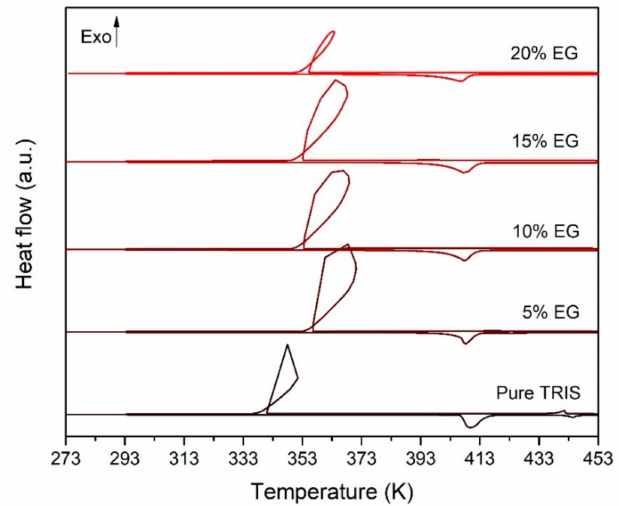
Figure 11. DSC thermograms obtained at a heating / cooling rate of 1 K / min for TRIS samples doped with EG micro-particles. EG content: 0%wt, 5%wt, 10%wt, 15%wt and 20%wt.